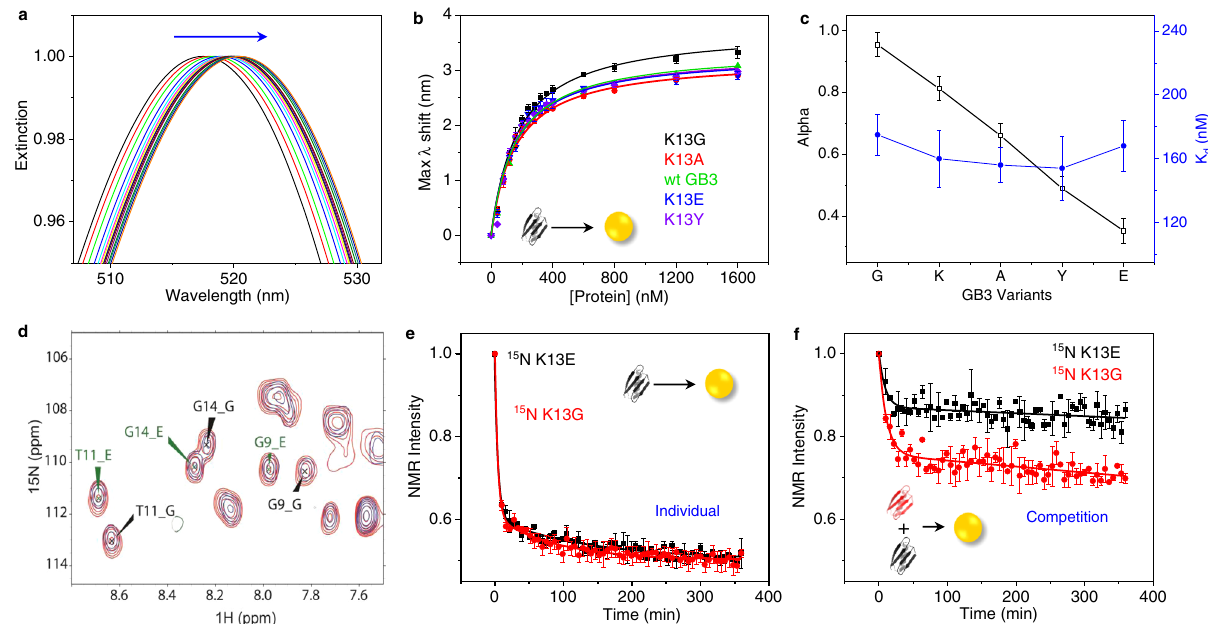
Fig.3|Roleofcompetitioninproteincoronaformation.a UV-vistitrationsofthe K13Y GB3 variant into AuNPs (different colors for each titration point). The arrow represents increasing red shifts of the AuNP peak. b Maximum wavelength of the AuNP peak in a plotted against protein concentrations for fi ve GB3 variants (K13G, black; K13A, red; WT, green; K13E, blue; K13Y, violet). Each dataset is fi t with Langmuir adsorption isotherm model. c A comparison of alpha values (black) obtained from competitive binding versus Langmuir dissociation constants ( K d , blue). d Example SOFAST-HMQC spectrum measuring the competitive binding of K13G (black labels, “ _G ” ) and K13E (green labels, “ _E ” ) to AuNPs. The red spectrum shows a control without AuNPs (0min), and the blue spectrum is measured with AuNPs at 365min. Complete spectra are presented in Supplementary Fig. 7. e Pro- tein peak intensity change as a function of AuNP incubation time for K13E (black) and K13G (red) GB3. After adding AuNPs, a spectrum was collected every 5min